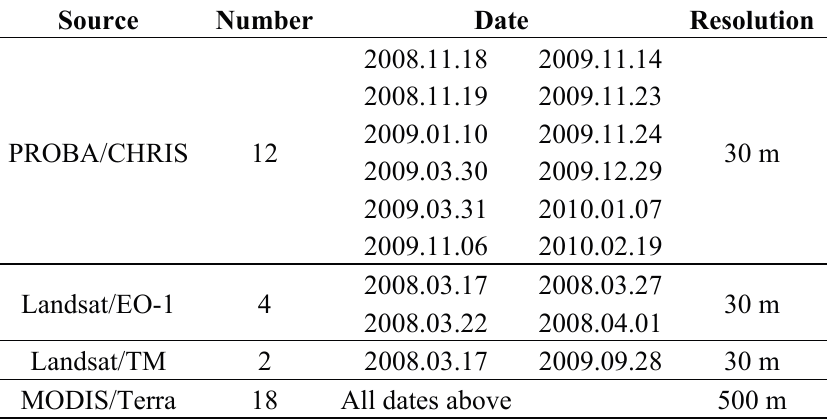
Table 1. Remote sensing data used in this